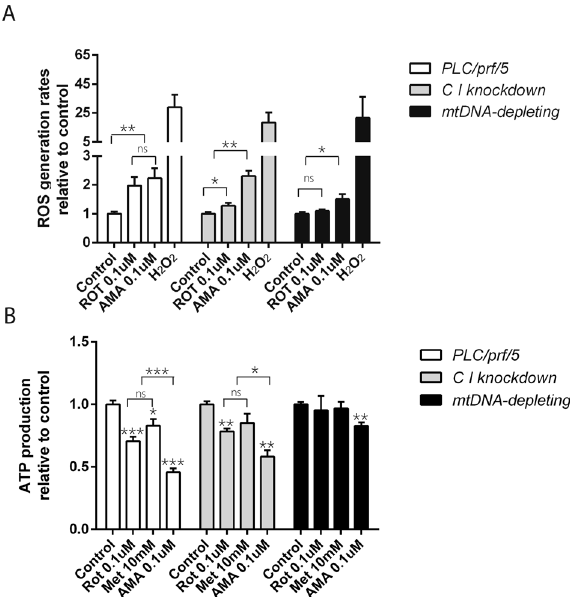
Fig. 6 Inhibition of mETC affects cellular metabolism. A ROS production was measured after treating cells with ETC complex I (ROT) and III (AMA) inhibitors in three HCC cell lines (PLC/PRF/5 cells, C I knockdown, and mtDNA depletion) ( N = 4). B After treating with ROT, Met, and AMA for 48 h, respectively, ATP production of PLC/ PRF/5 cells, C I knockdown and mtDNA-depletion HCC cells were measured. ( N = 9). Results were presented as mean ± SD, and group differences were tested by one-way ANOVA. * p < 0.05; ns, not signi fi